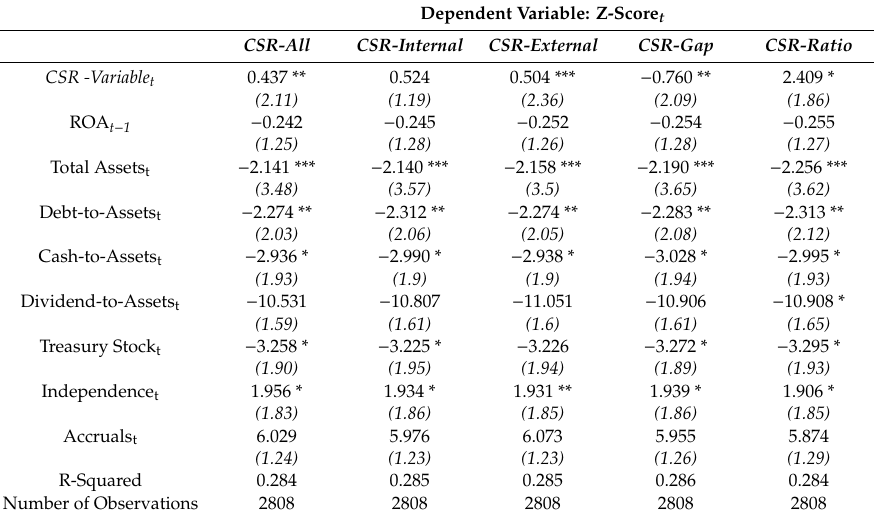
Table 5. Bank Risk and Corporate Social Responsibility. This table presents the OLS results from estimating Equation (2), or the impact that Corporate Social Responsibility has on bank risk, as measured with Z-Score . In the first model, CSR-All is the CSR variable; in the second model, CSR-Internal is the CSR variable; in the third model, CSR-External is the CSR variable; in the fourth model, CSR-Gap is the CSR variable; and in the fifth model, CSR-Ratio is the CSR variable. These and all other variables are defined in Appendix A. Standard errors are clustered at the firm level. Intercepts and firm and year fixed e ff ects are included in the model but not tabulated. Coe ffi cients are presented with t-statistics below in parentheses. Statistical significance is indicated with *** for 1%, ** for 5% and * for